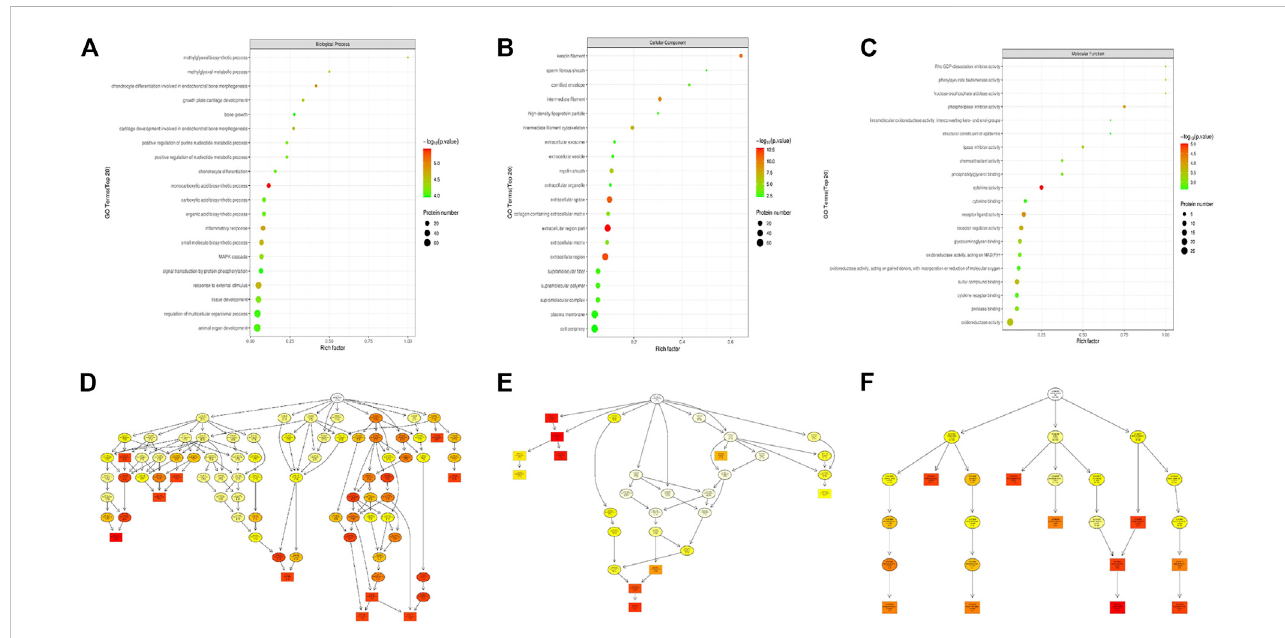
FIGURE 2 KEGG pathway enrichment analysis of differentially expressed proteins in loperamide-treated HT22 cells. (A) KEGG pathway annotation statistics for differentially expressed proteins. (B) KEGG pathway differential expression analysis map. (C) KEGG pathway enrichment bubble